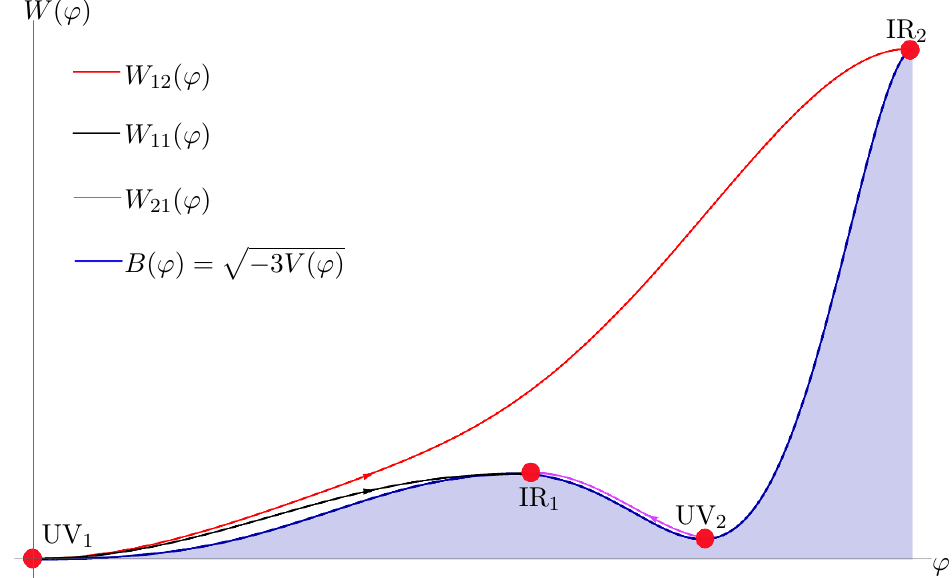
Figure 24. The plot represents the superpotentials corresponding to the three regular holographic RG (cid:13)ow solutions arising from the potential in (cid:12)gure 23. Two of them are standard interpolating from UV 1 to IR 1 and from UV 2 to IR 1 . The third one skips IR 1 and ends up at IR 2 . The shaded region is the forbidden region below the critical curve B ( ’ ). The arrows represent the direction of the (cid:13)ow from the UV to the